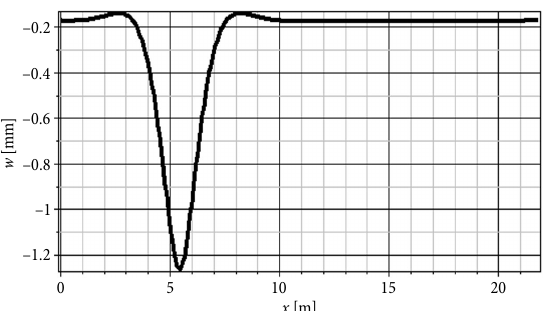
Fig. 7. The initial displacements of the rail under a static load equal to 100 kN